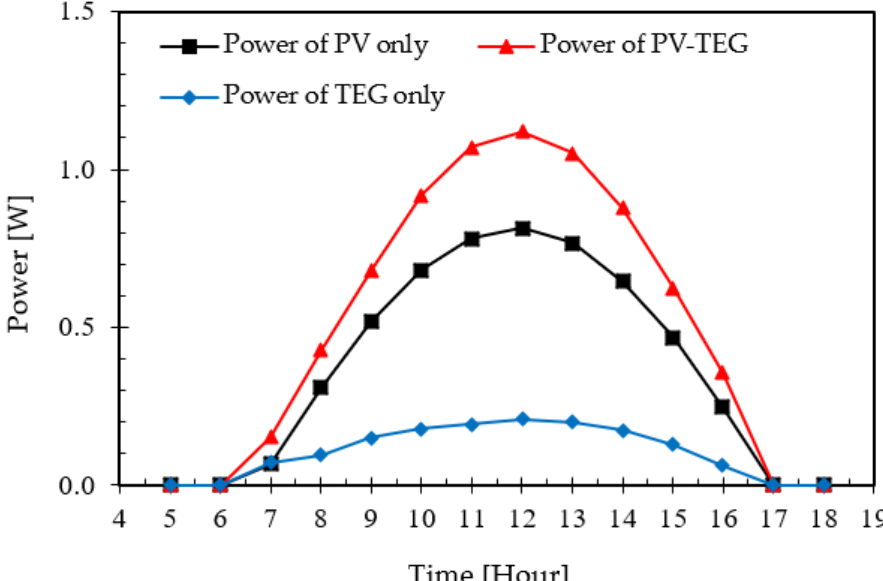
Figure 11. Power output of PV, PV-TEG, and TEG.